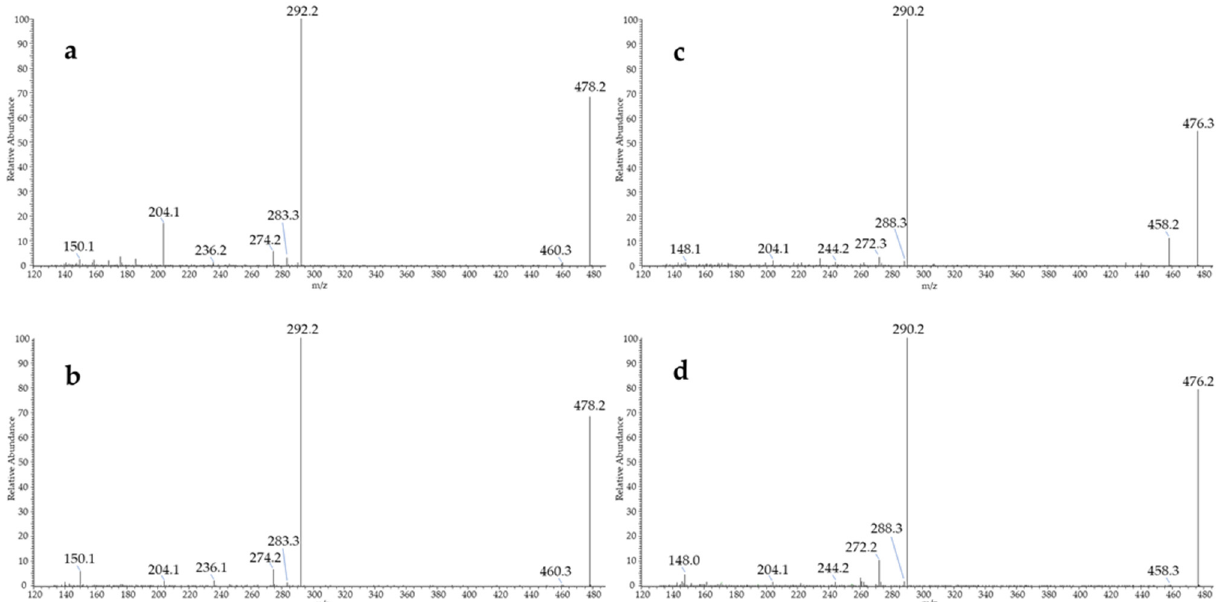
Figure 4. MS/MS spectra of the BBHA derivatives of 9-oxo-octadecadienoic acid obtained from ( a ) rat fecal water and ( b ) standard compound, and of the BBHA derivatives of 9-oxo-octadecatrienoic acid from ( c ) rat fecal water and ( d ) standard compound.